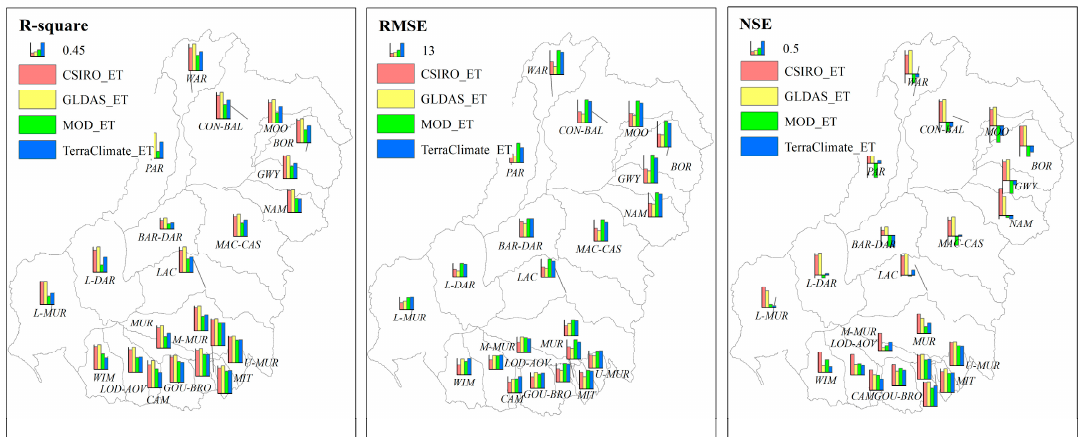
Figure 7. Bar plots showing the statistics ( R 2 , RMSE and NSE ) of monthly ET estimated with CSIRO ET , GLDAS ET , MOD ET and TerraClimate ET products within the 22 catchments of the Murray Darling Basin when compared with the monthly AWAP ET levels. The embedded bar plots with numbers at the upper-left corners are the scales for interpreting the bars associated with each catchment.